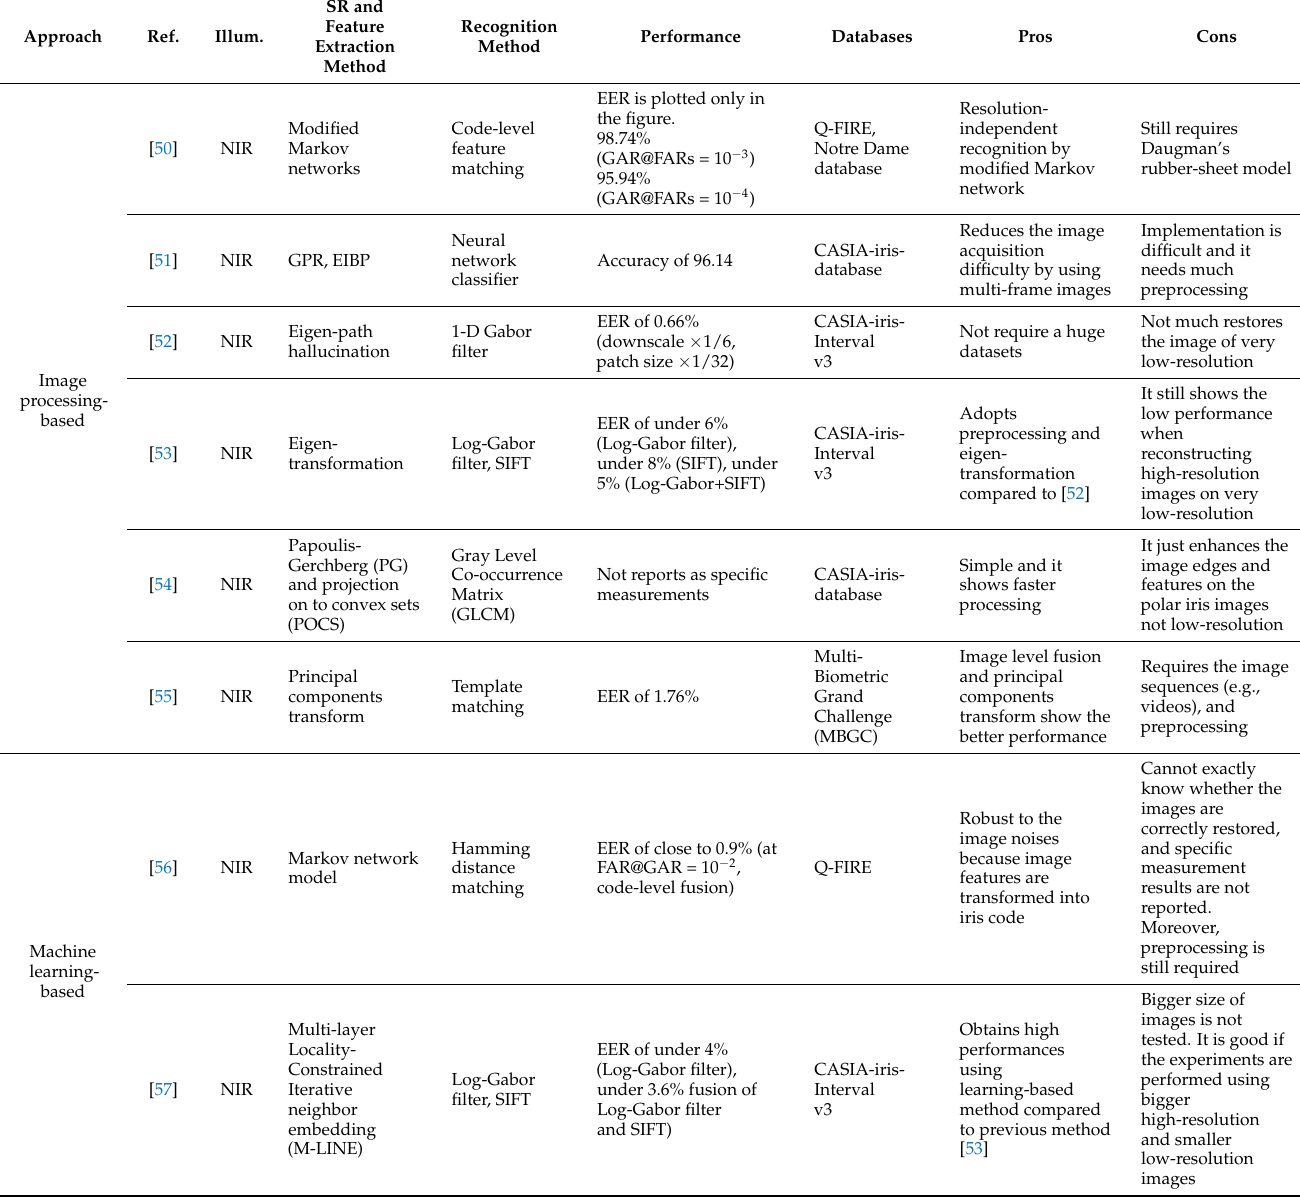
Table 3. Research into iris recognition with low-resolution images (Ref. and Illum. denote reference and